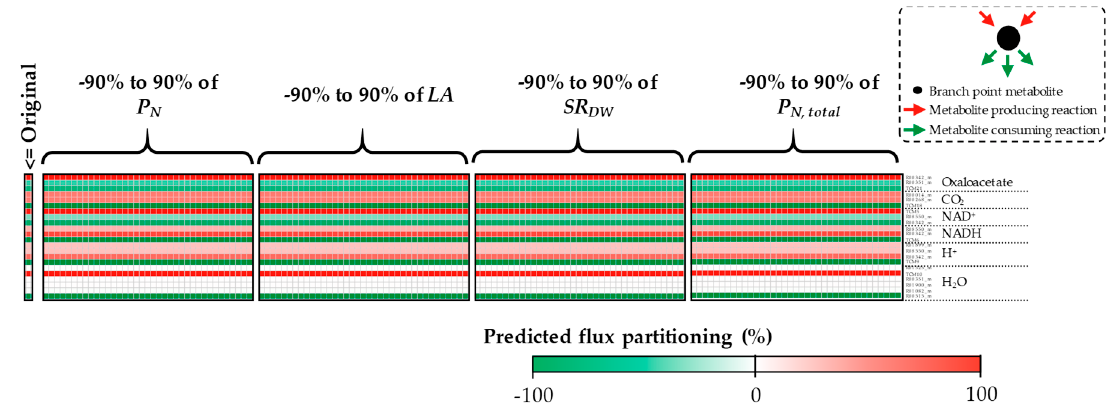
Figure A7. The sensitivity of the mitochondrial reaction flux partitioning to variations in the sucrose uptake rate-related data. Details of the metabolic branch points along with the corresponding reactions are provided in the Supplementary Materials (File S2). A di ff erence in grid color between the original (first column) and predicted fluxes is indicative of dissimilarity in partitioning (breakpoint). The production and consumption fluxes at each metabolic branch point were respectively, denoted as positive and negative signs. LA ; total leaf area per plant; P N , photosynthetic rate; P N, total , total photosynthetic rate per plant; SR DW , storage root dry weight per plant.